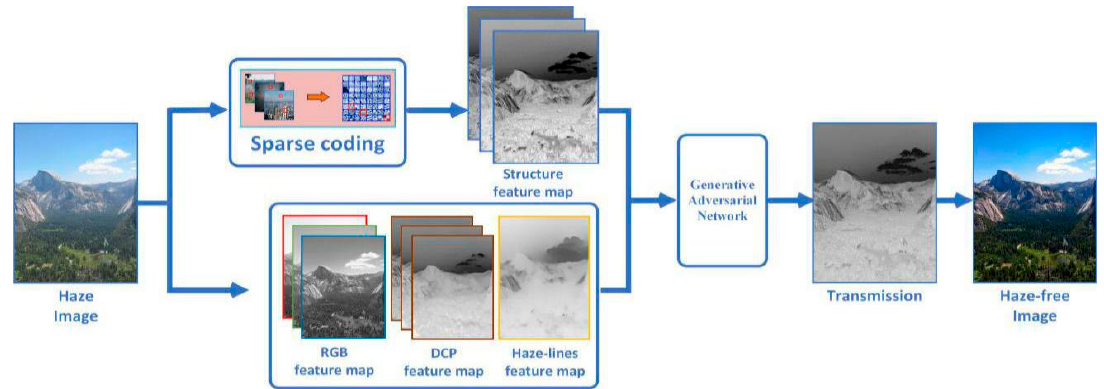
Figure 3. The flow of our method.